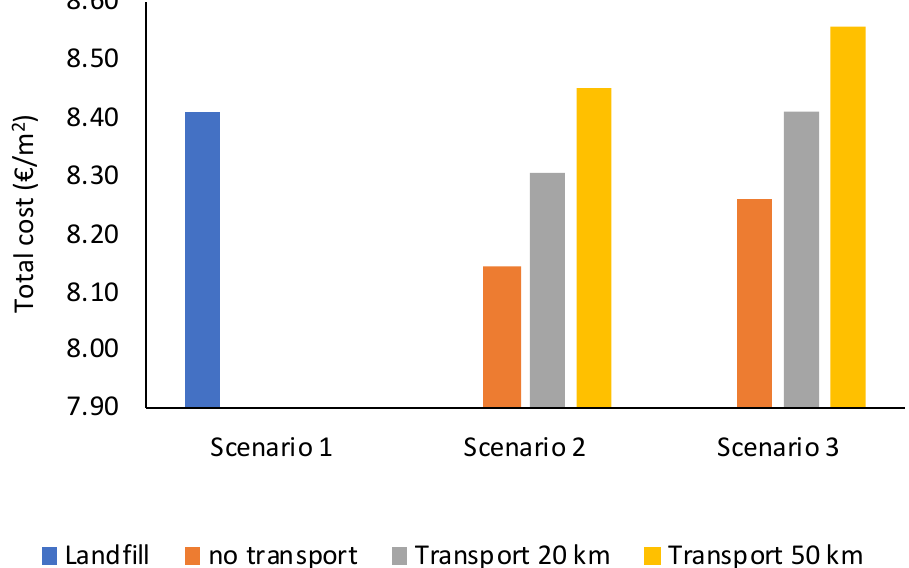
Figure 6. Sensitivity analysis of the production cost considering 0 km, 20 km, and 50 km transport